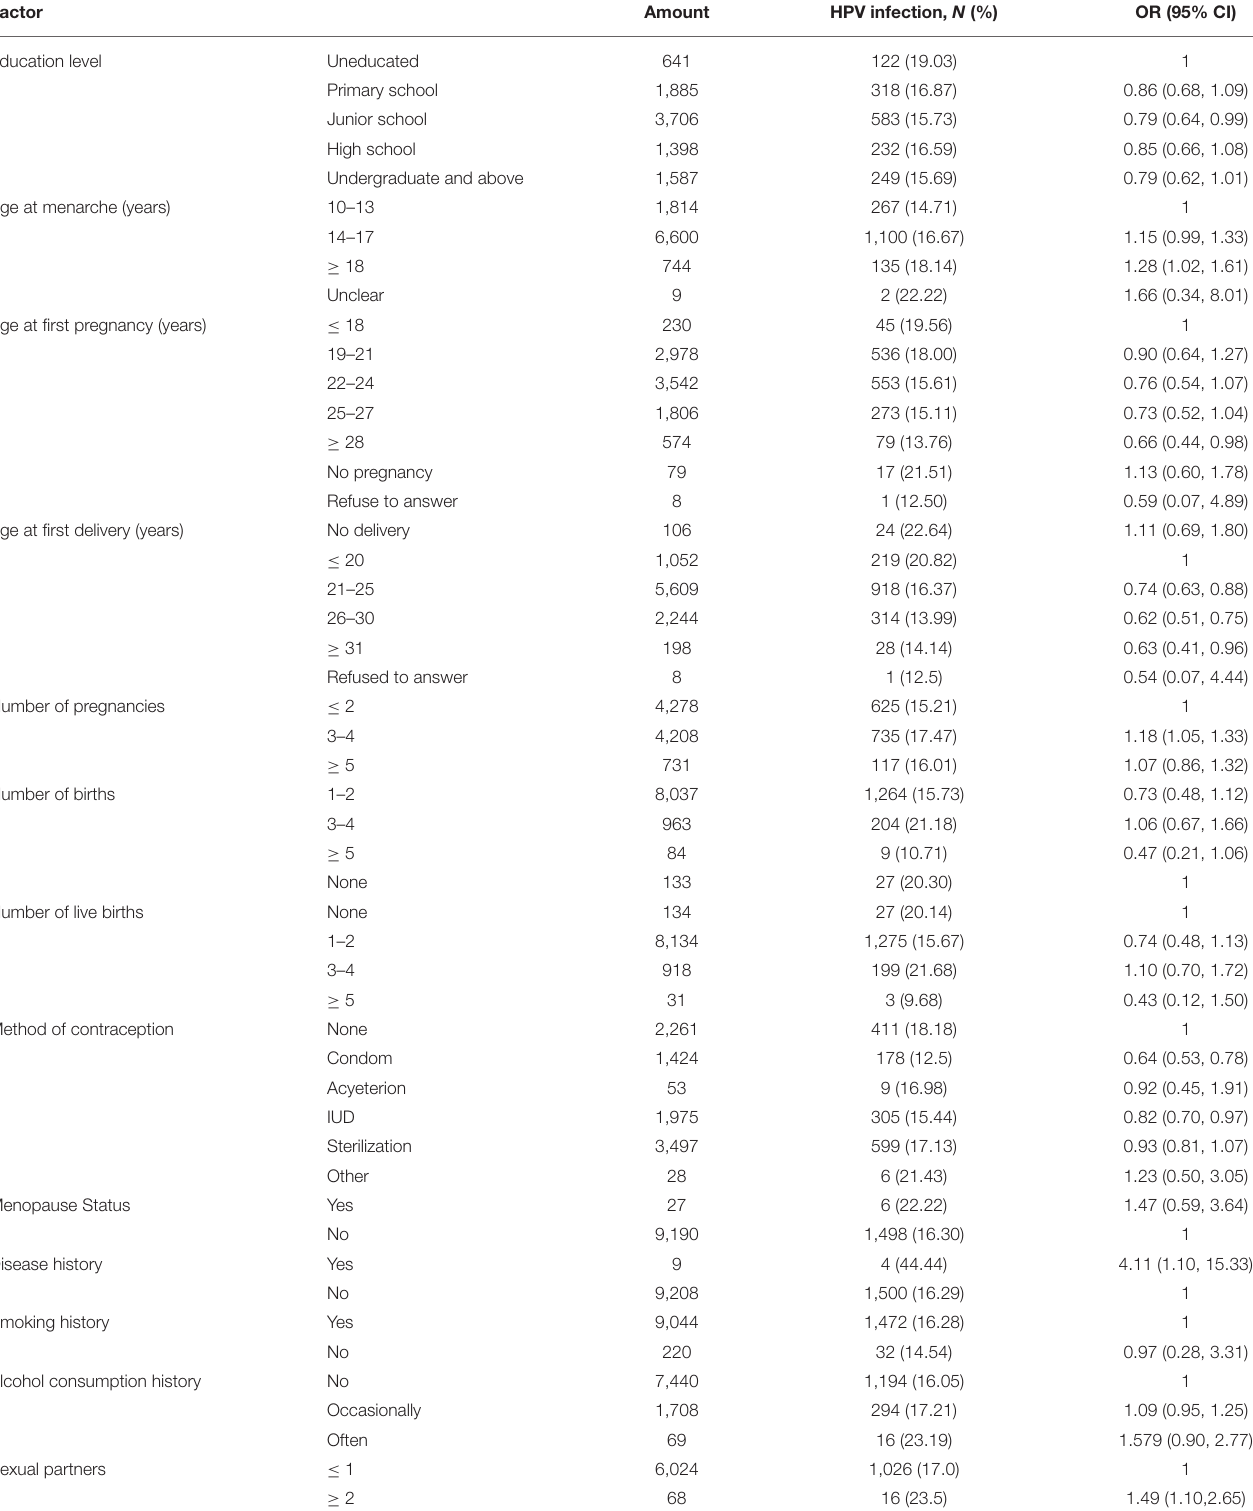
TABLE 3 | Analysis of factors associated with high-risk HPV infections.